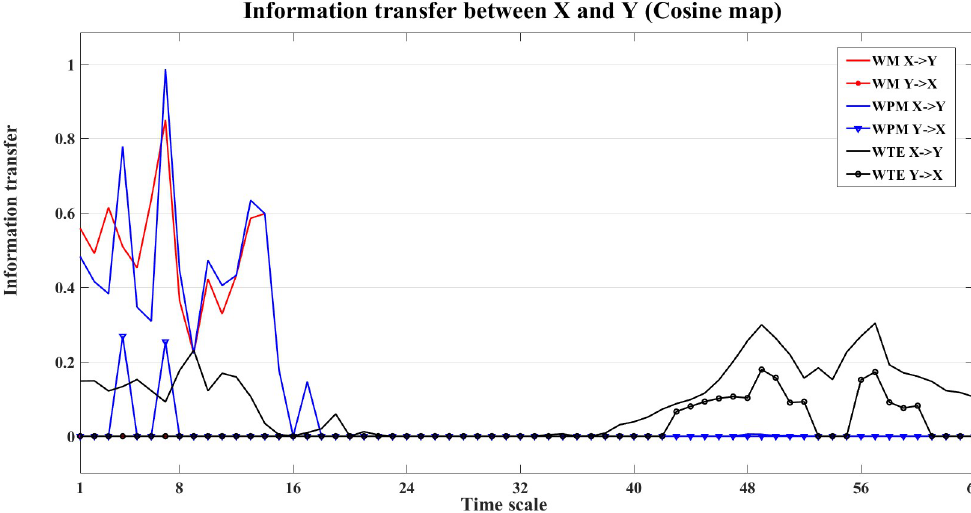
Fig 5. Information transfer between X and Y. In this figure, we present the WM (red), WPM (blue) and WTE (black) information transfer values of cosine map (coupling strength e = 0.8) in each independent direction. We can see that all measures present dominant information transfer values for X- > Y.